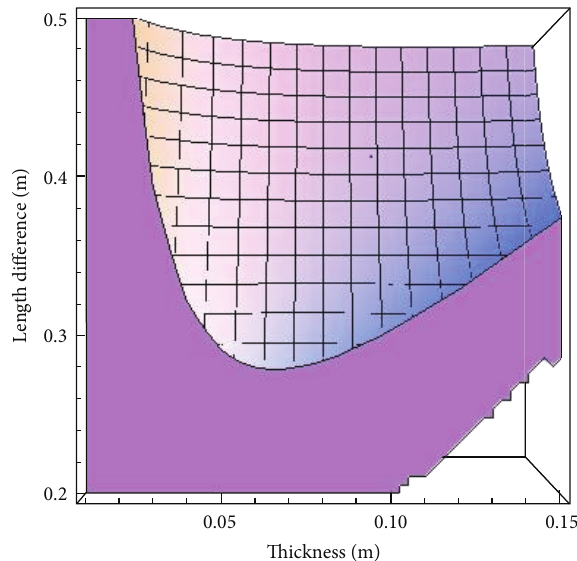
Figure 3: 𝑇 𝑖 (𝑡) along wall thickness and length difference between the inner and outer